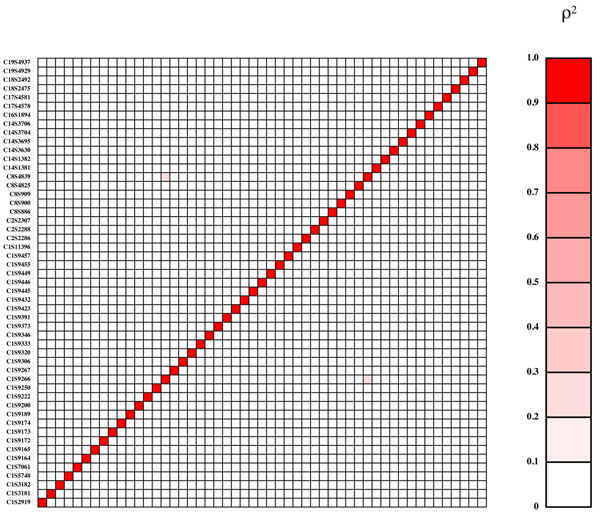
Gametic disequilibrium (r2) between functional variants for latent liability. Markers are shown in chromosomal order from bottom to top and from left to right and are symmetric across the diagonal.